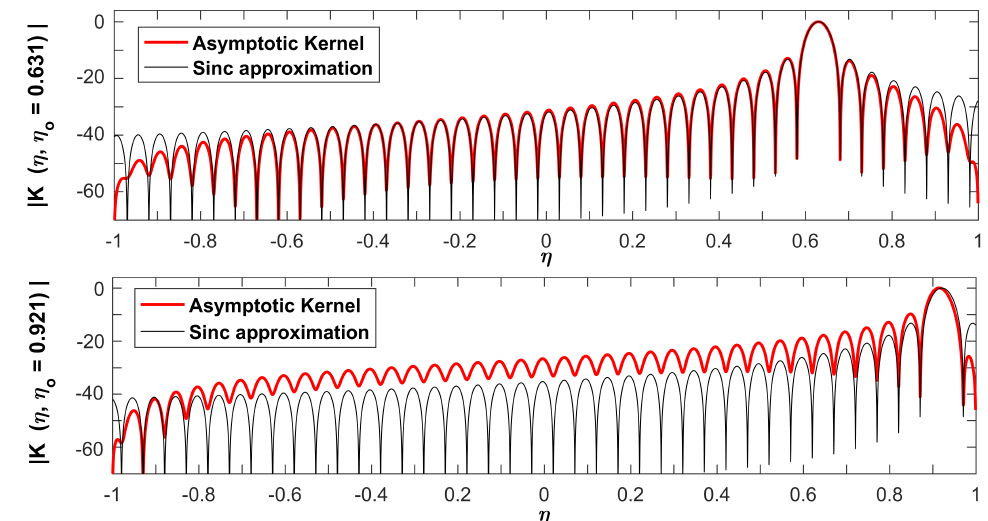
Figure 4. Behavior of | K ( η ) | in dB for η o = 0.631 ( x o = 7.5 λ ) and η o = 0.921 ( x o = 15 λ ). The diagrams refer to the configuration a = 10 λ ( η ( a ) = 0.78), and z o = 5 λ .